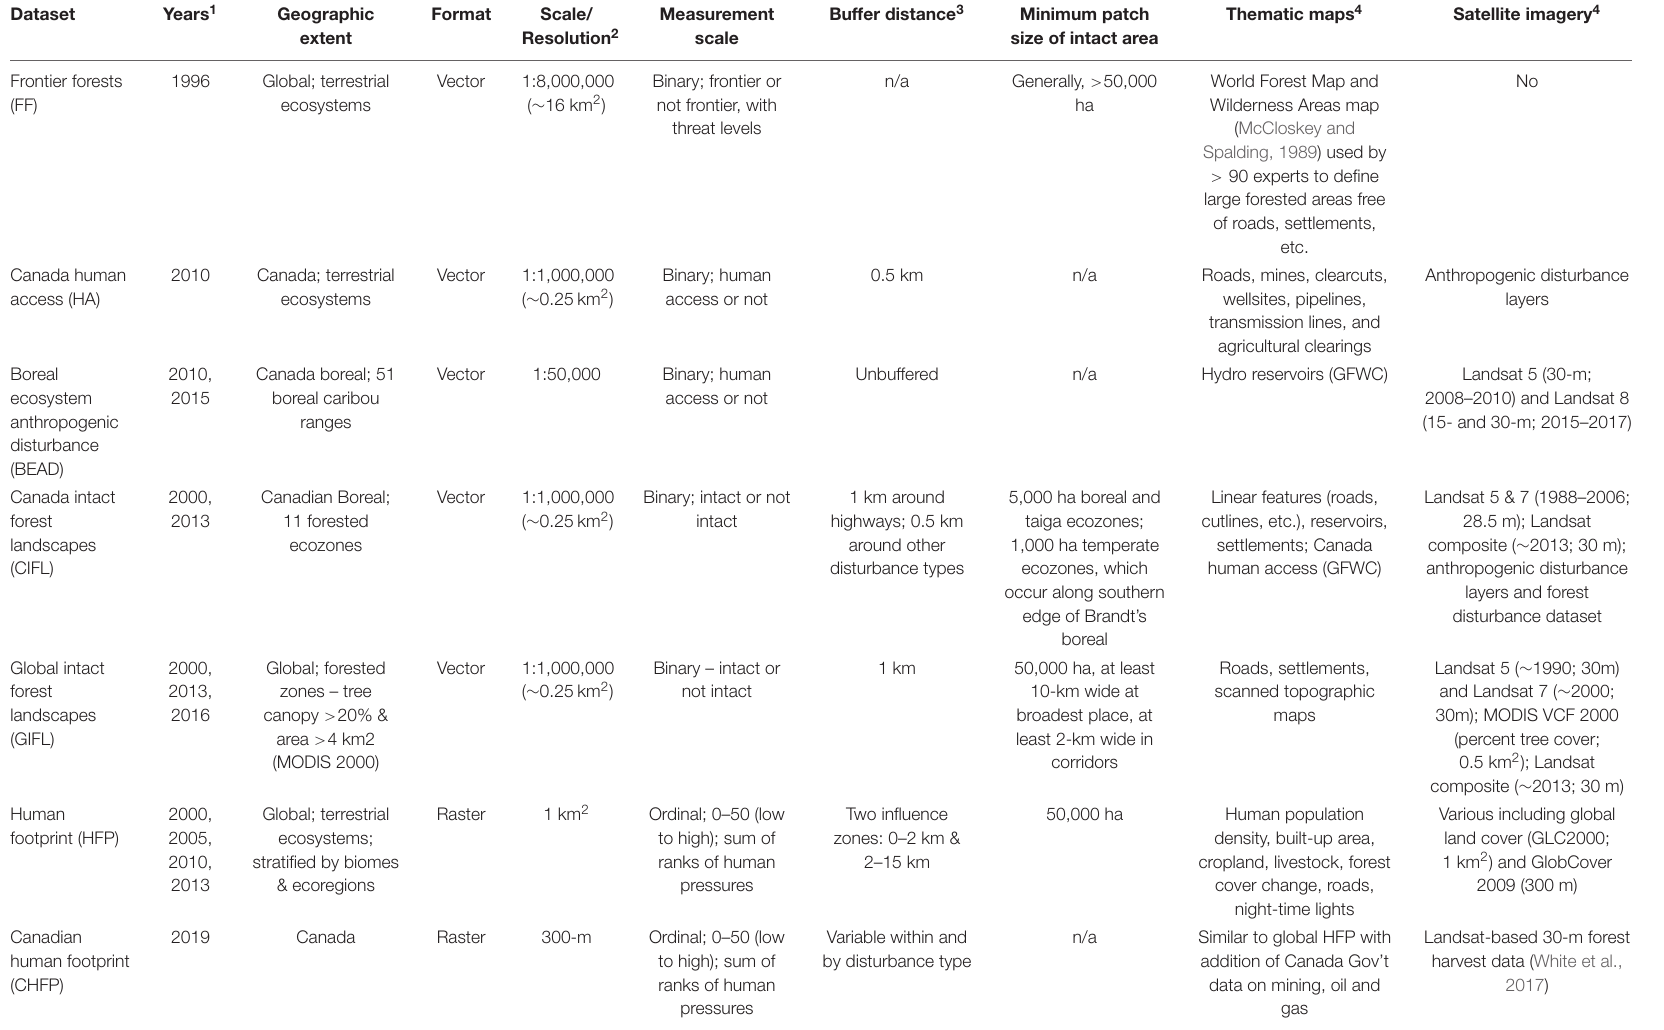
TABLE 1 | General characteristics of intactness and human influence maps reviewed in this study including geographic extent, format, resolution, measurement scale, buffer distance, minimum patch size, and sources of input data (i.e., thematic maps and satellite imagery).